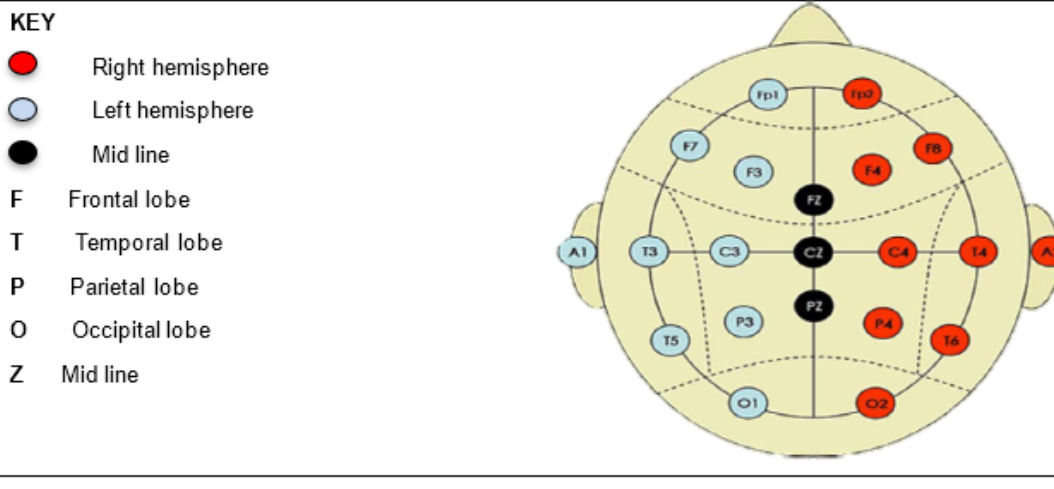
Figure 1. The international 10-20